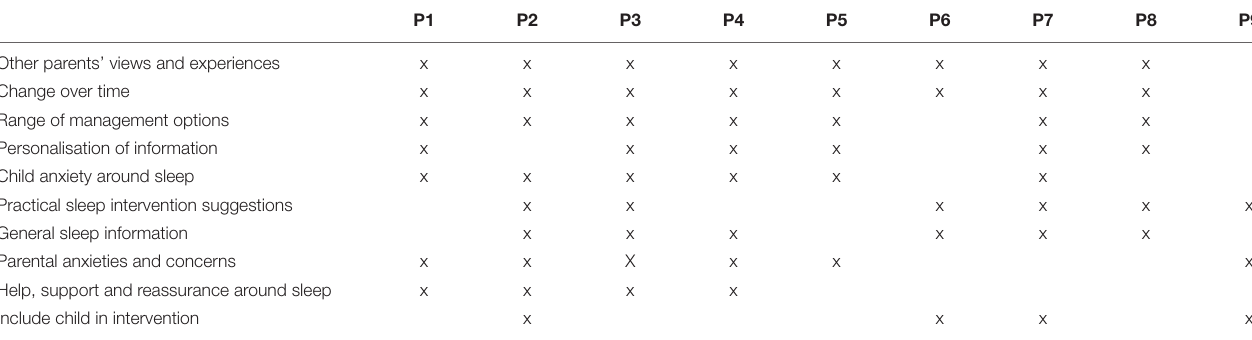
TABLE 2 | Summary of themes identified and by which participants they were reported.